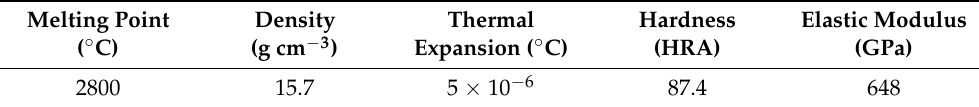
Table 5 . Machining Conditions . Voltage ( V )